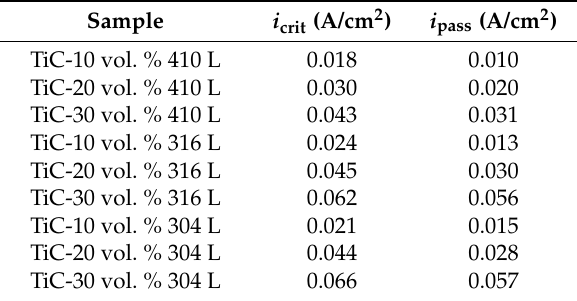
Table 3. Electrochemical results following potentiodynamic polarisation, showing the critical current density, i crit , and the minimum current density in the pseudo-passive region, i pass , for the cermets.